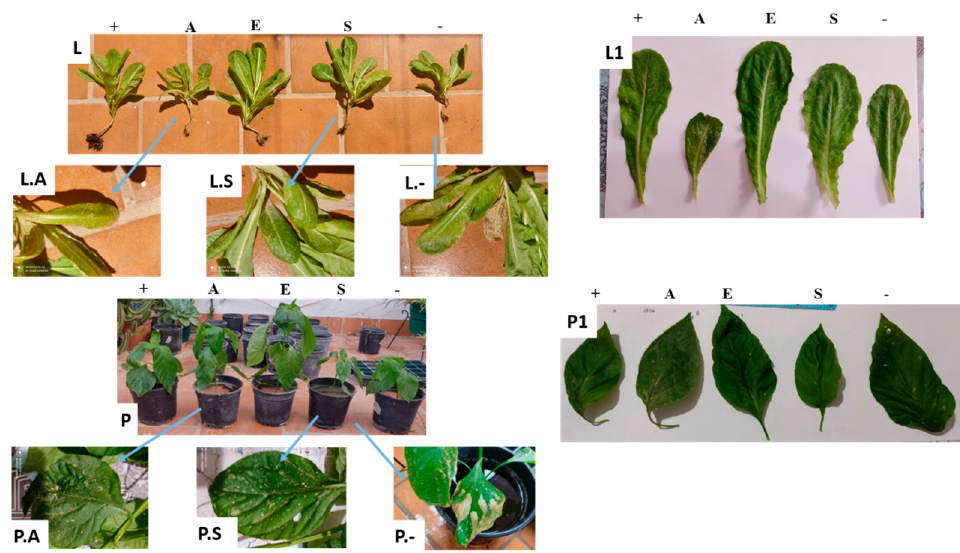
Figure 7. Photographs of lettuces (L) and peppers (P) fertilized with the different matrices (A, E, S), by conventional fertilization (+) or without fertilization ( − ). L.-, L.A, L.S, P.-, P.A and P.S: detailed pictures of visual deficiencies. L1 and P1: comparison of the largest leaves of each crop. Table 5. Characteristics of crops fertilized with the different matrices (A, E, S), by conventional fertilization (+) or without fertilization ( − ). Different letters and roman numerals mean significant differences.